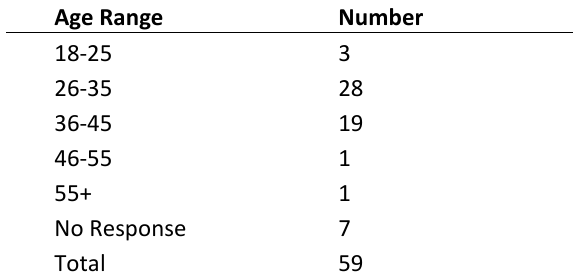
Table 1. Participant age range.